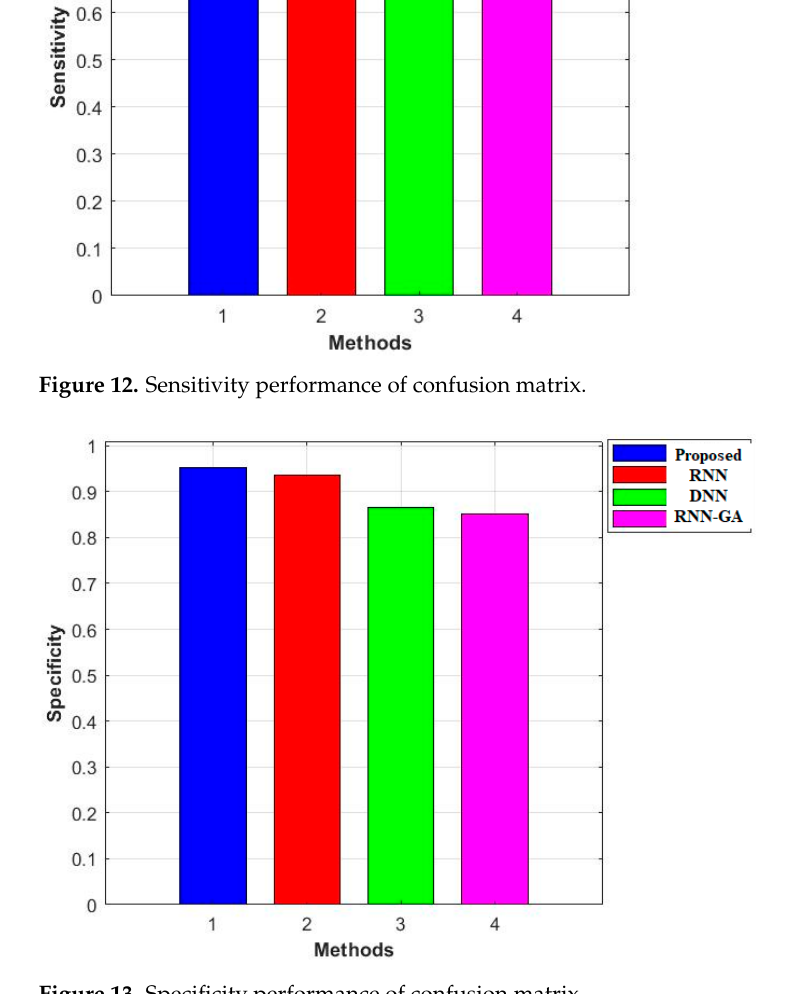
Figure 13. Specificity performance of confusion matrix. Table 4. Accuracy comparison of different combination rules based on the NSL-KDD test